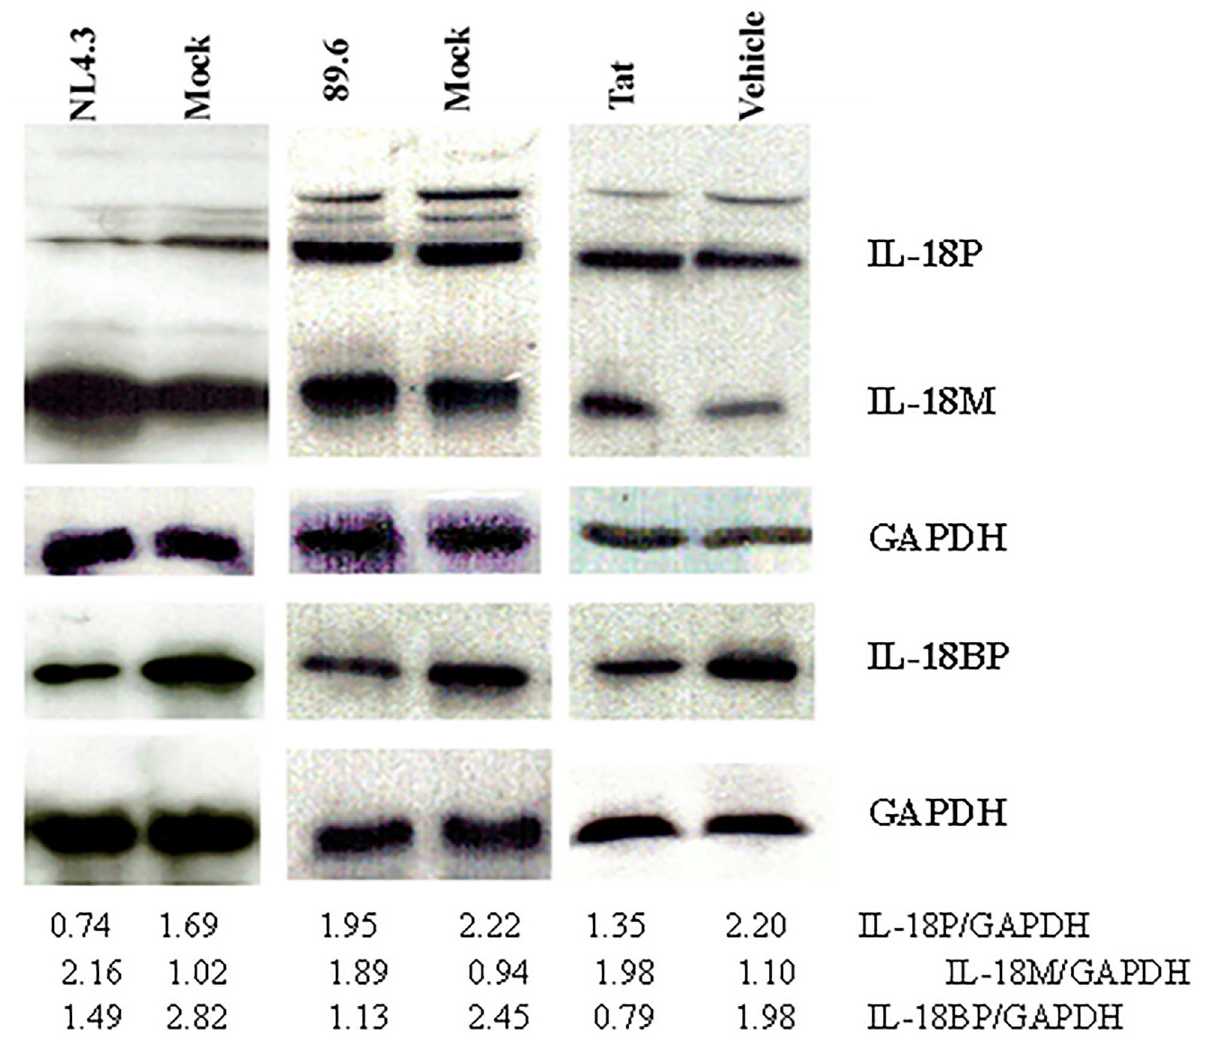
Fig 1. HIV treatment increases IL-18 but decreases IL-18BP in IEC. HT-29 monolayers (~ one million cells) were infected with 10 6 infectious units of NL4.3, 89.6, or treated with Tat (100 ng/ml). After 24 hours, precursor IL-18 (IL-18P), mature IL-18 (IL-18M) and IL-18BP were detected in the cell lysates (25 ug of the lysate proteins) by Western blots. The Figure shows a representative of several experiments. GAPDH was detected as a control for protein loading. Note that the viral as well as Tat treatment increases expression of mIL-18 and decreases that of IL-BP. The ratios of band densities for each protein to the control are shown below the